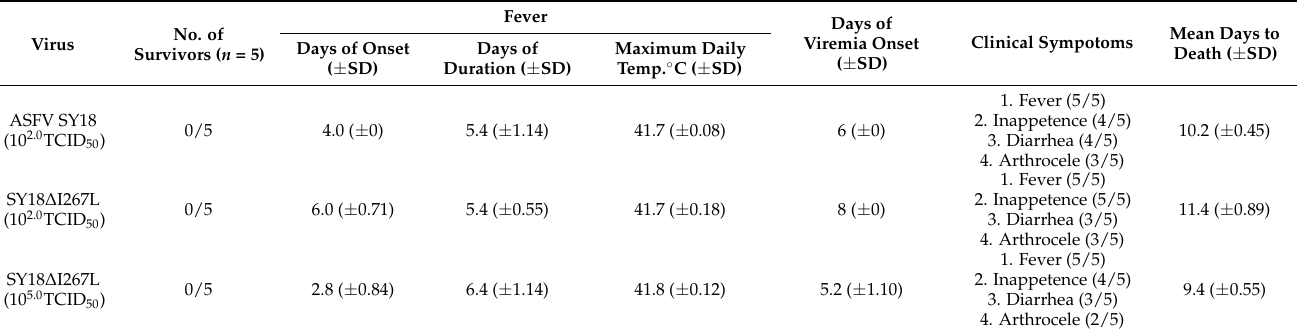
Table 2. Survival and fever responses of pigs inoculated with SY18 ∆ I267L and ASFV SY18.